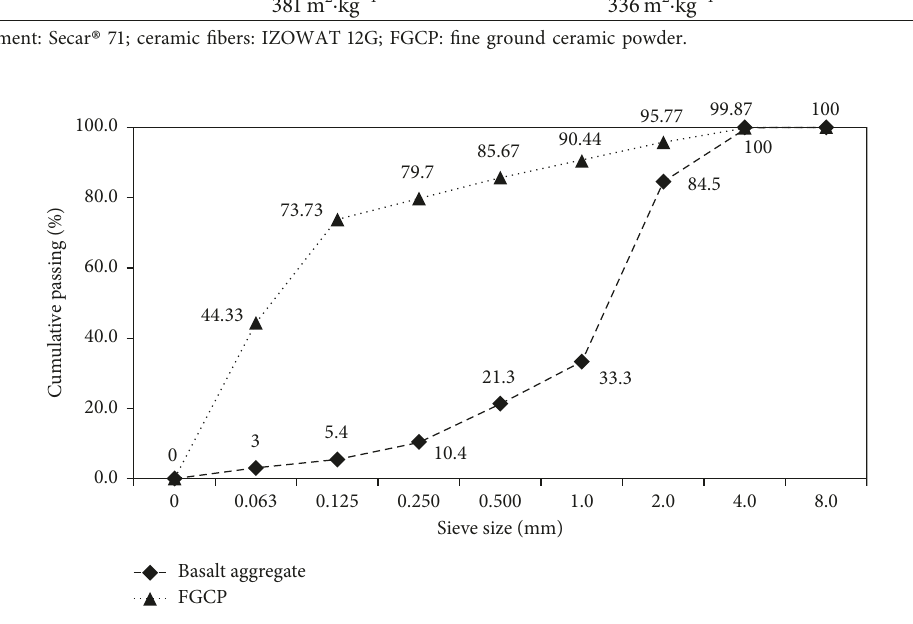
Figure 2: Gradation curve of used aggregate and